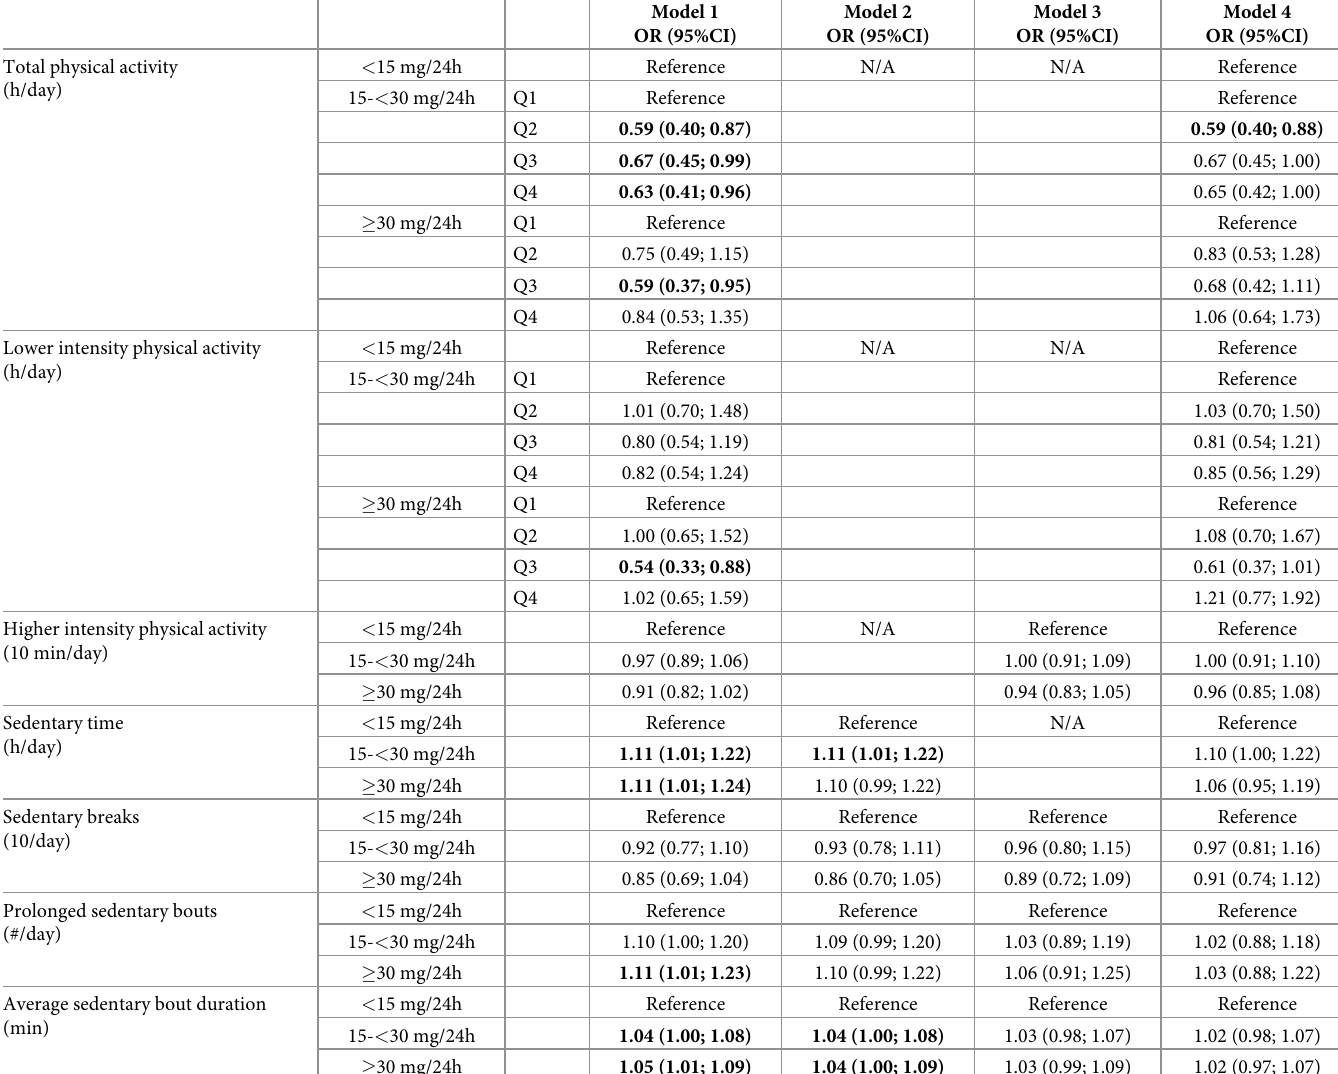
Table 5. Associations of physical activity and sedentary behavior variables with